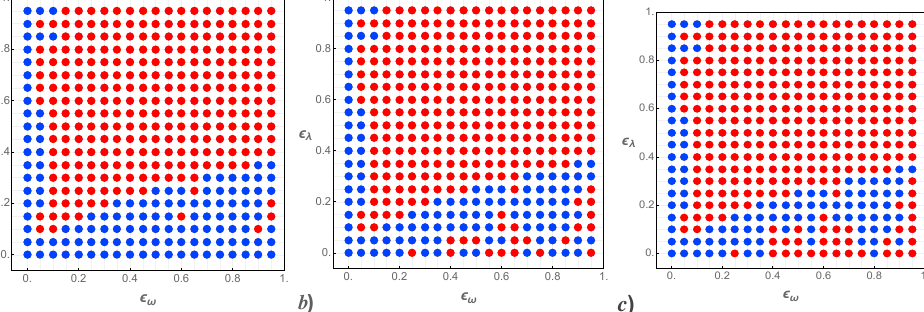
Figure 8. Illustration of the change of the parametric plane in three different times. ( a ) Corresponds to a maximal time of t max = 3000 time units, ( b ) t max = 5000 time units and ( c ) t max = 10000 time units. The figure is own